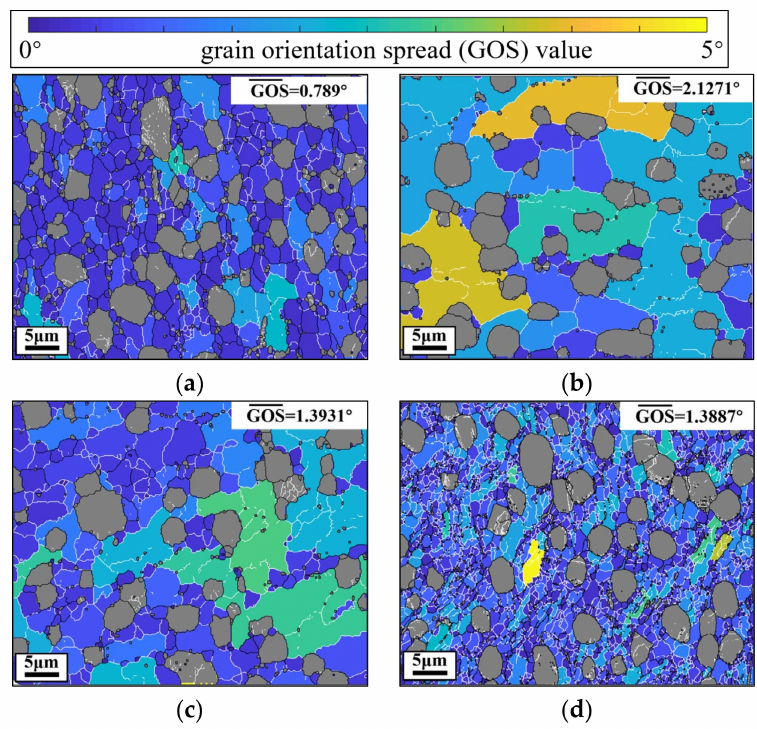
Figure 6. GOS maps of the Ti-55511 alloy compressed at: ( a ) 1003 K–0.1 s − 1 –0.5–0.001 s − 1